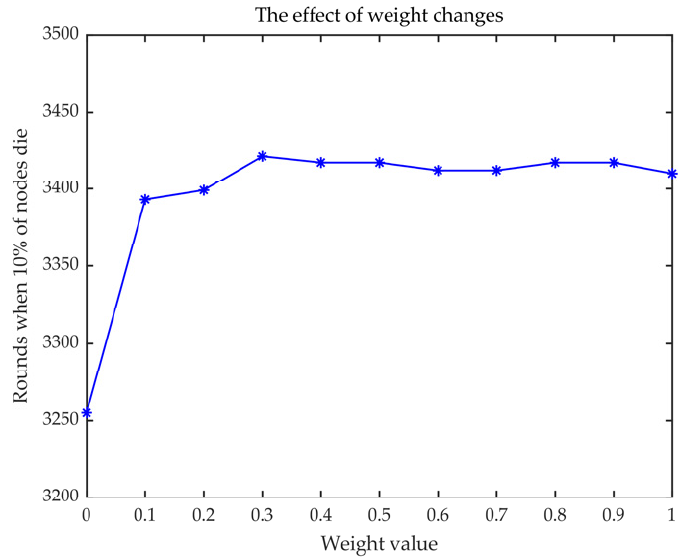
Figure 5. Selection weight of Formula (11).